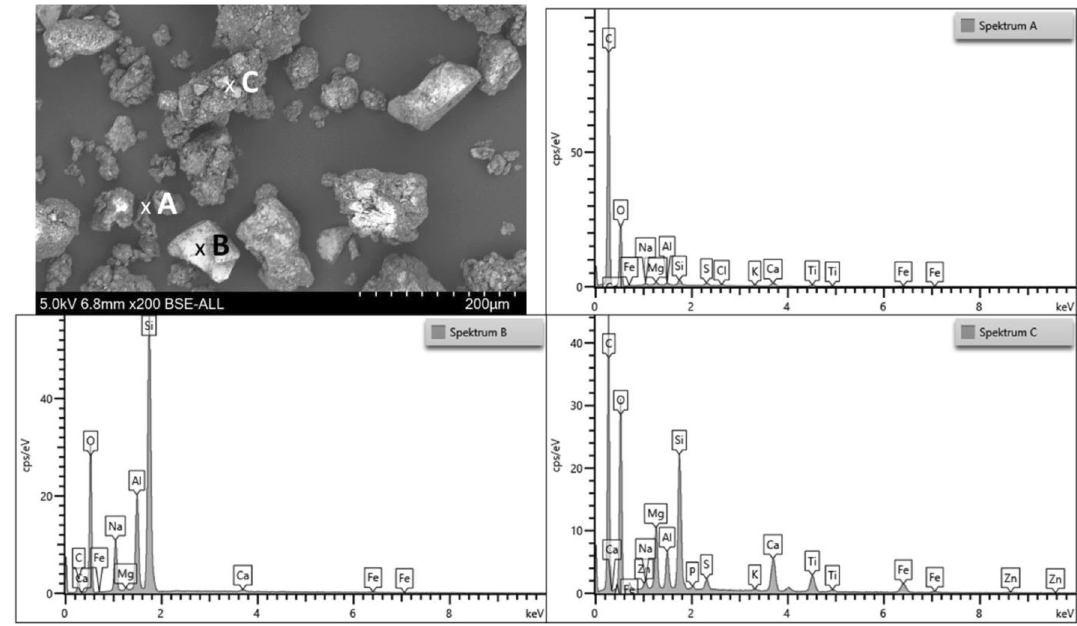
Figure 9. Elemental spectra of TWAP: ( A ) rubber particle, ( B ) mineral particle and ( C ) agglomerate of different particles.